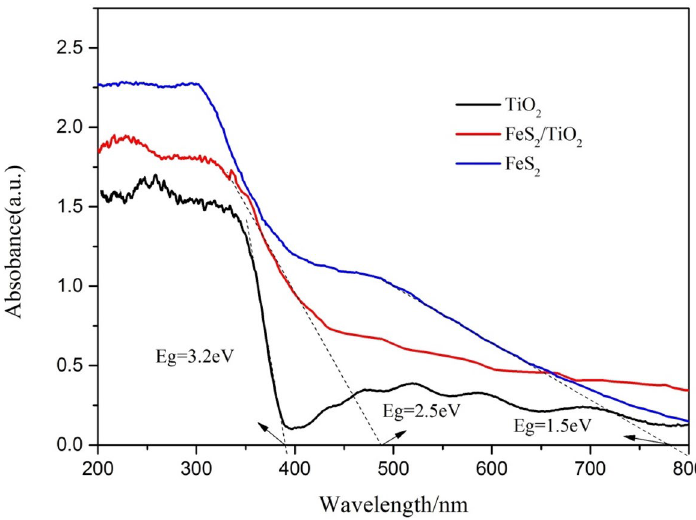
Figure 7. UV–vis diffraction reflectance spectra of the pure TiO 2 , pure FeS 2 and FeS 2 /TiO 2.